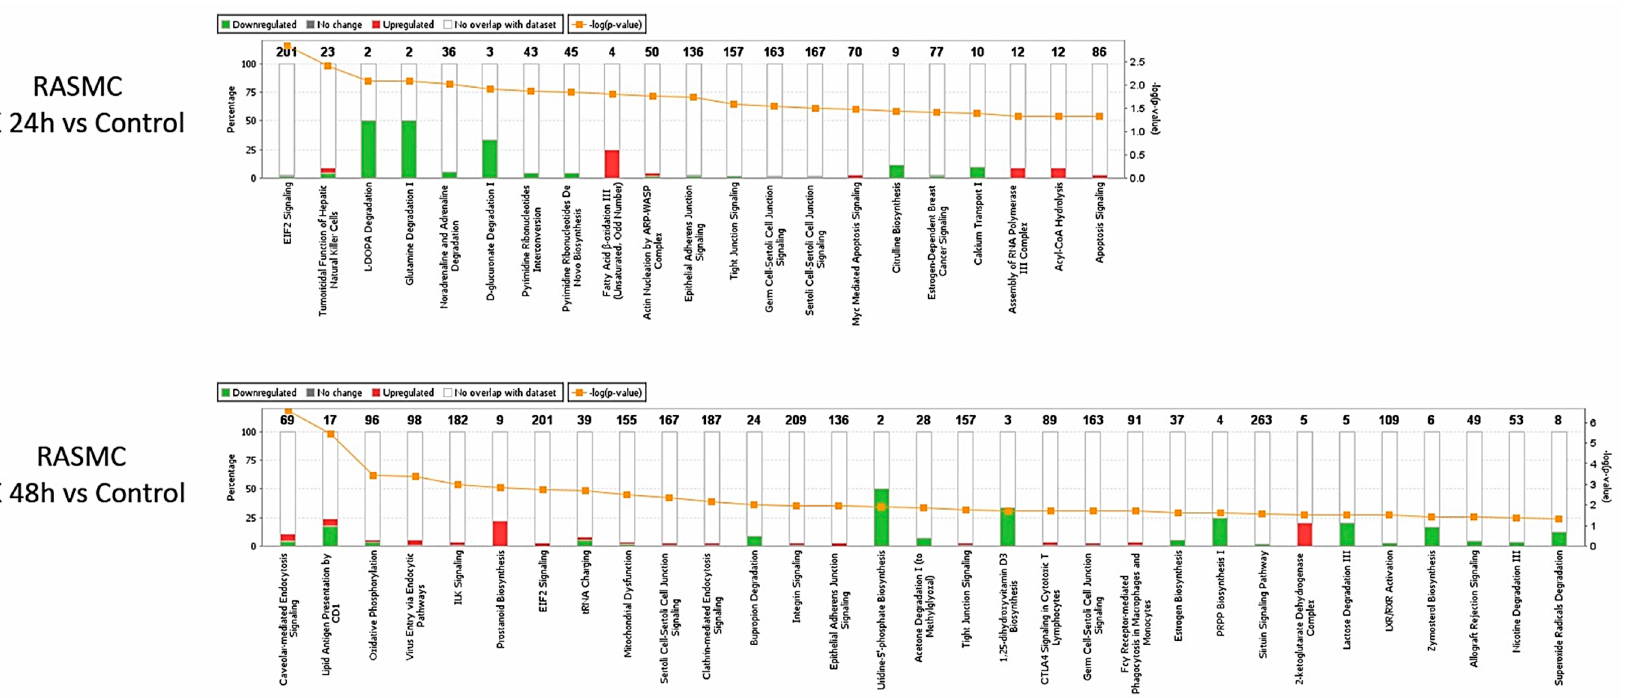
Figure 2. The regulated canonical pathways in response to BK stimulation in RASMC samples. Altered canonical pathways in response to the protein profile in the BK 24 h and 48 h stimulated vs. control samples. Each altered canonical pathway is represented in a bar graph. The downregulated proteins are represented by green on the graph, whereas the upregulated proteins are represented by red on the graph.